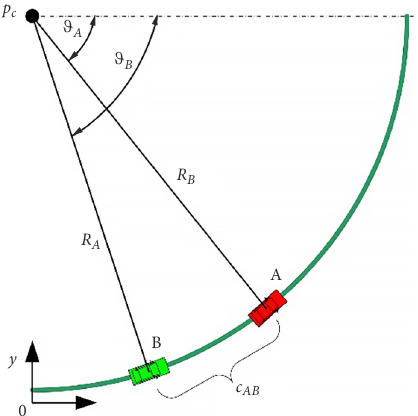
Figure 2. Example of two vehicles on curve road with constant radius (source: created by the authors)